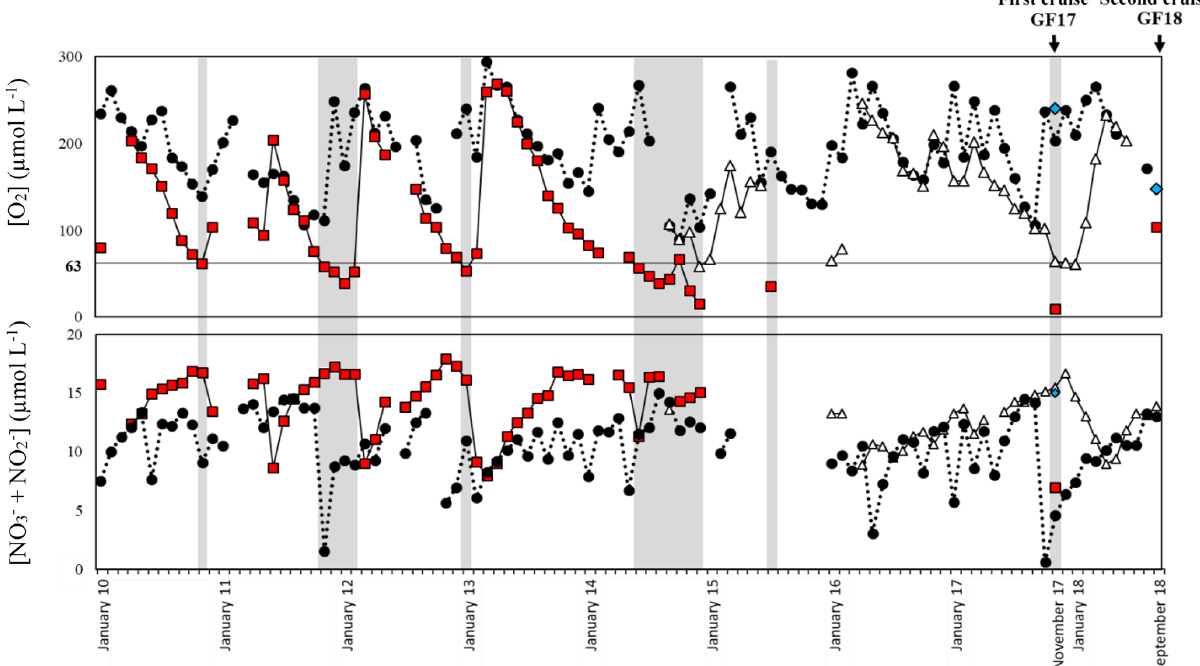
+ NO − ]) measurements 3 2